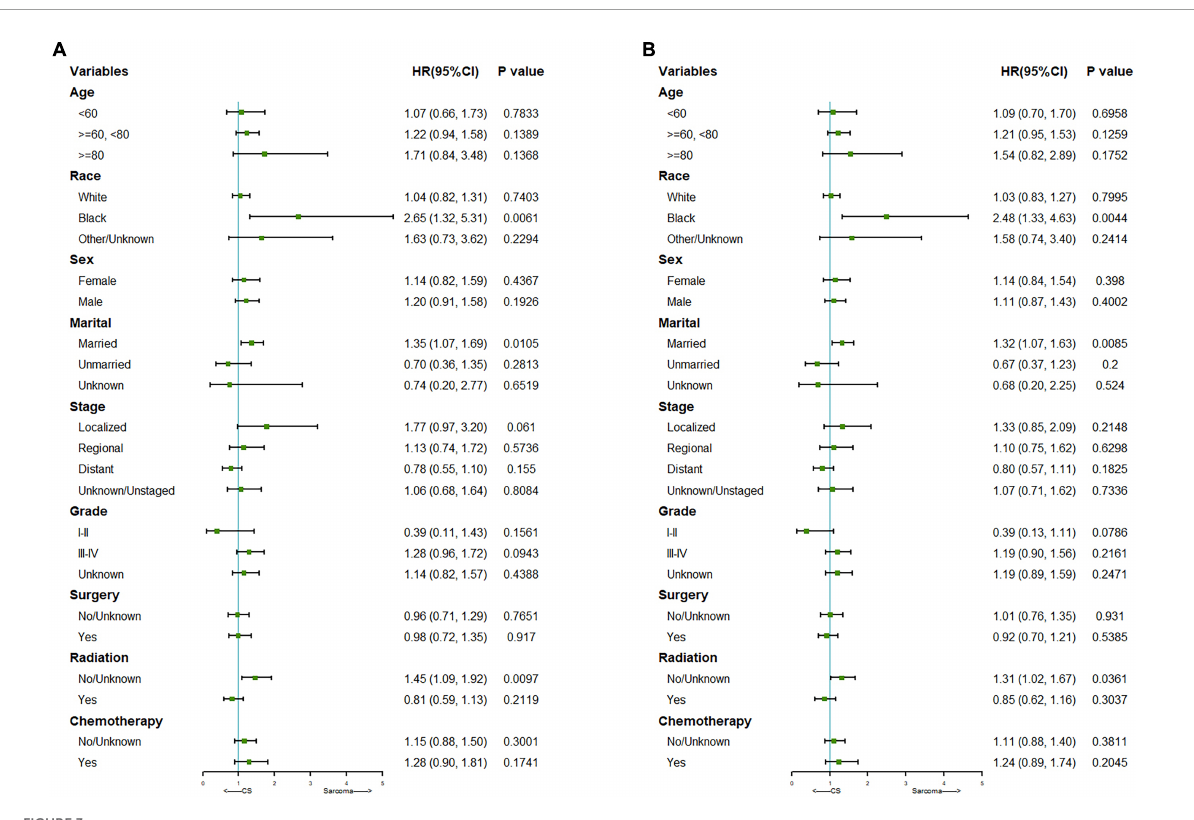
FIGURE3 Subgroup analysis for CSS (A) and OS (B) of the matched PCS and PS